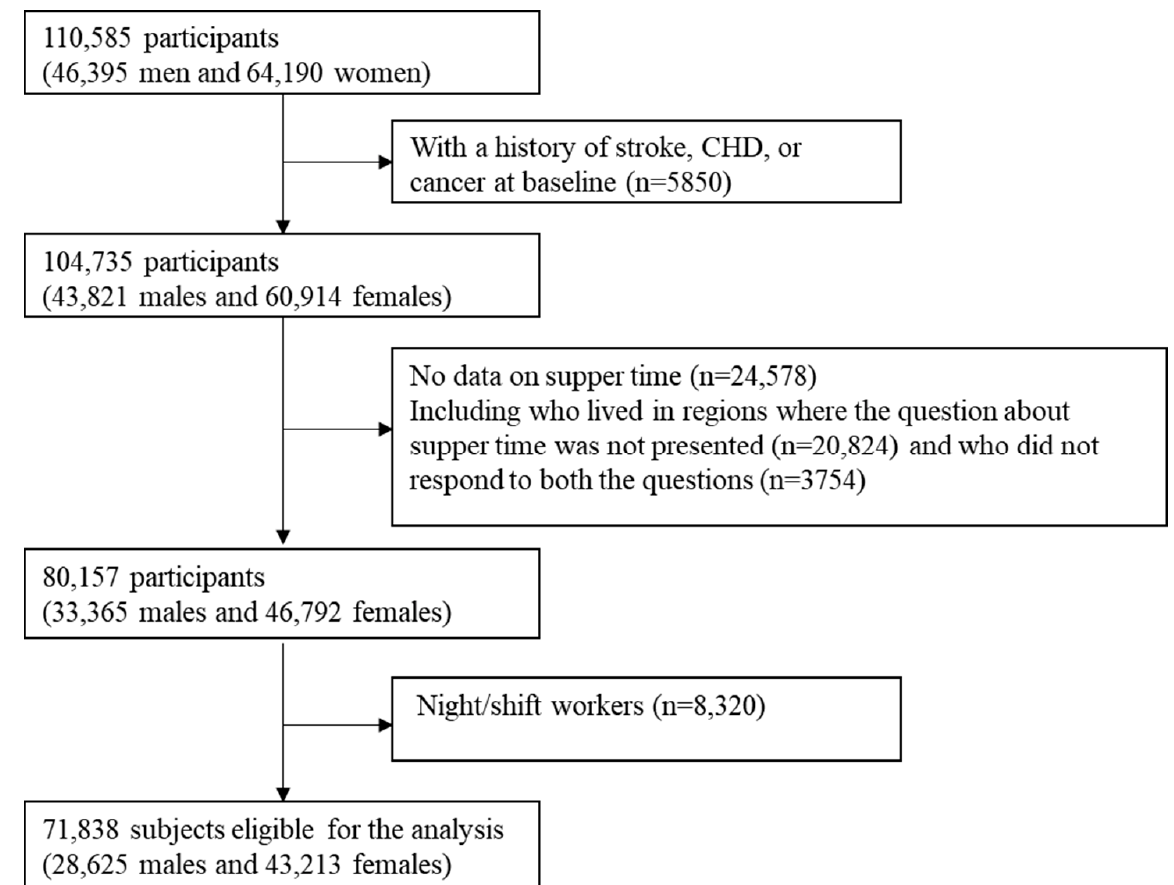
Figure 1. Flowchart of participant selection.